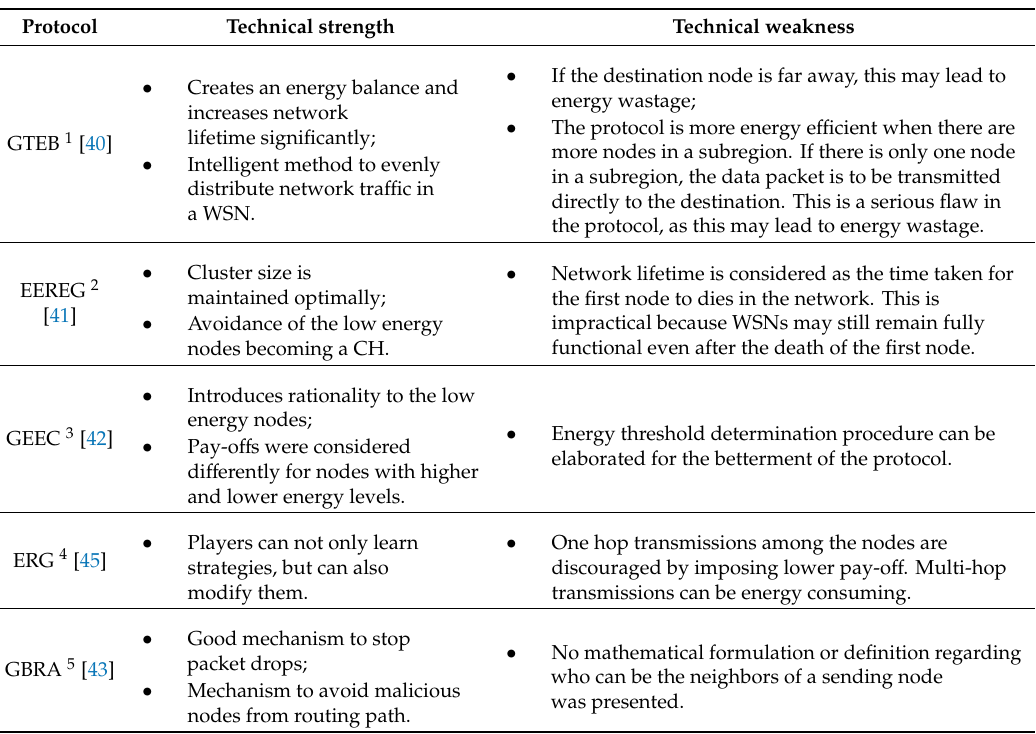
Table 6. Comparison of routing protocols based on evolutionary and reputation-based games in terms of technical strengths and